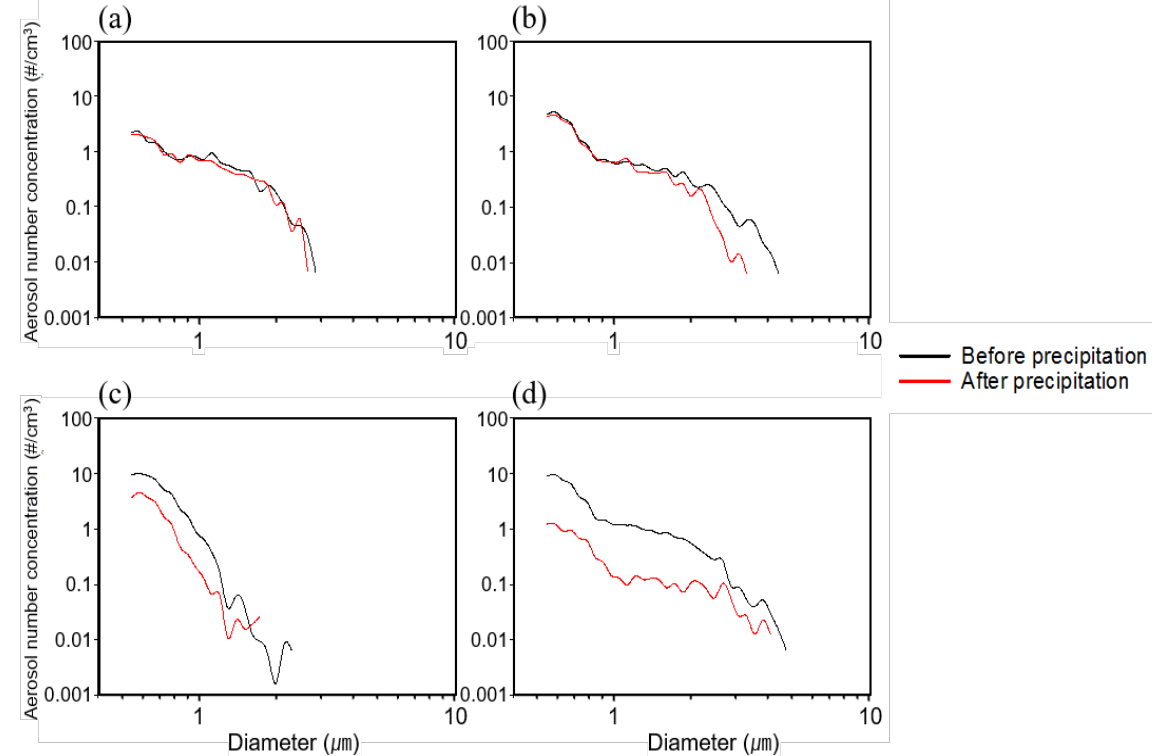
Figure 3. Observed aerosol number concentration before and after precipitation from ( a – d ) (cases 1 to 4).